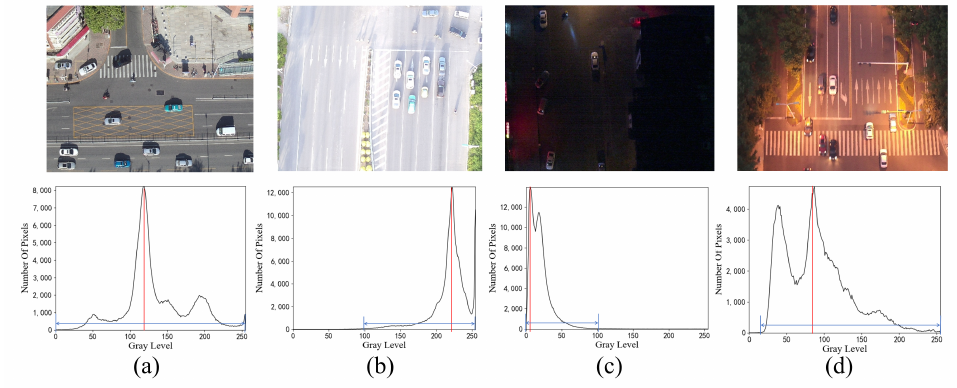
Figure 3. First row shows the UAV images under different illumination conditions: from ( a – d ) are bright, foggy, weak light at night, and strong light at night; the second row shows the corresponding gray-level histograms: the red line represents the gray level at peak frequency and the blue line shows the range of gray levels having a frequency greater than